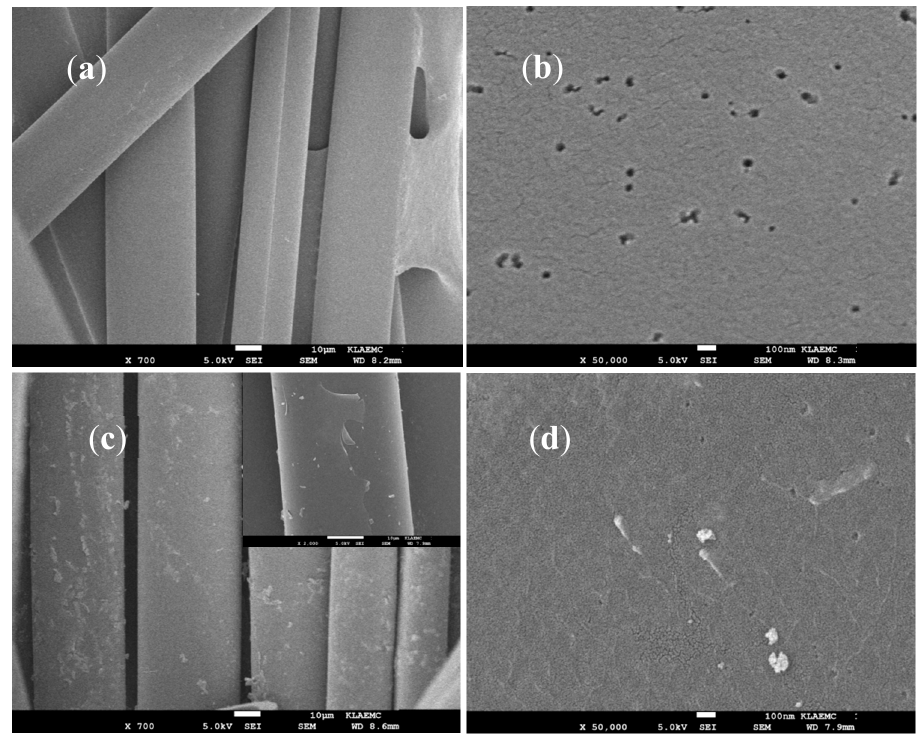
Figure 1. Scanning electron micrographies of the surface of wood-based activated carbon fiber (WACF) ( a , b ) and Mn/TiO 2 –WACF ( c , d ).